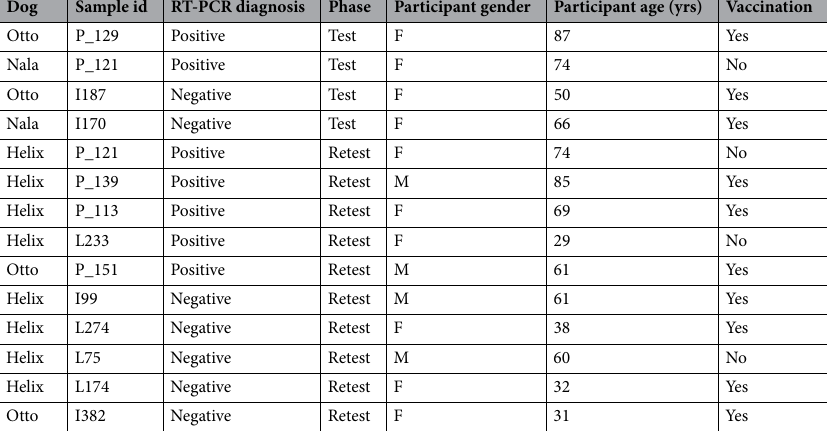
Table 3. Main biological characteristics of samples and experimental phase (test/retest) associated to discrepancies between SARS-CoV-2 RT-PCR and the response from the three dogs.